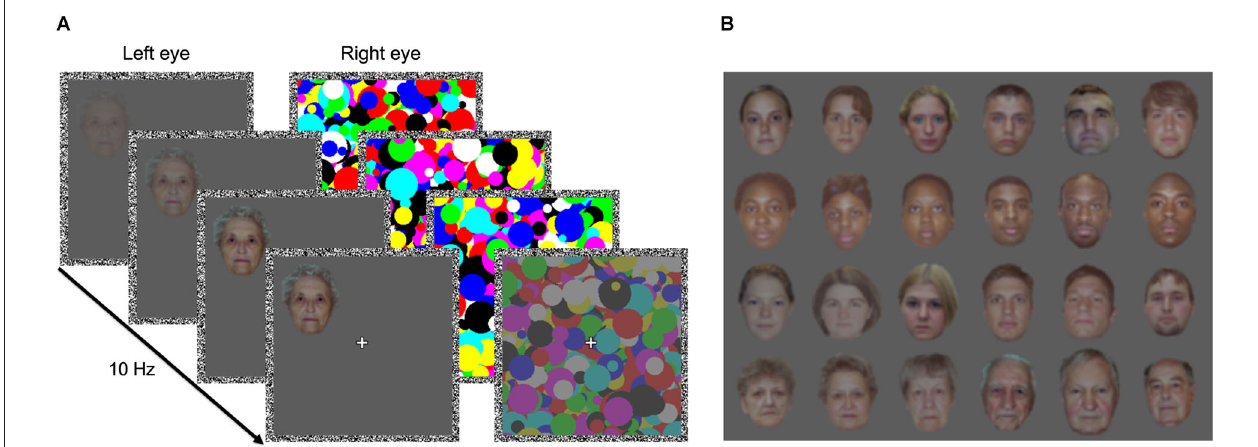
Participants indicated as quickly and accurately as possible on which side of fixation the target or any part of the target became visible. (B) Example face stimuli. Rows from top to bottom: young Caucasian adults from the race experiment, young Black adults from the race experiment, young Caucasian adults from the age experiment, and old Caucasian adults from the age